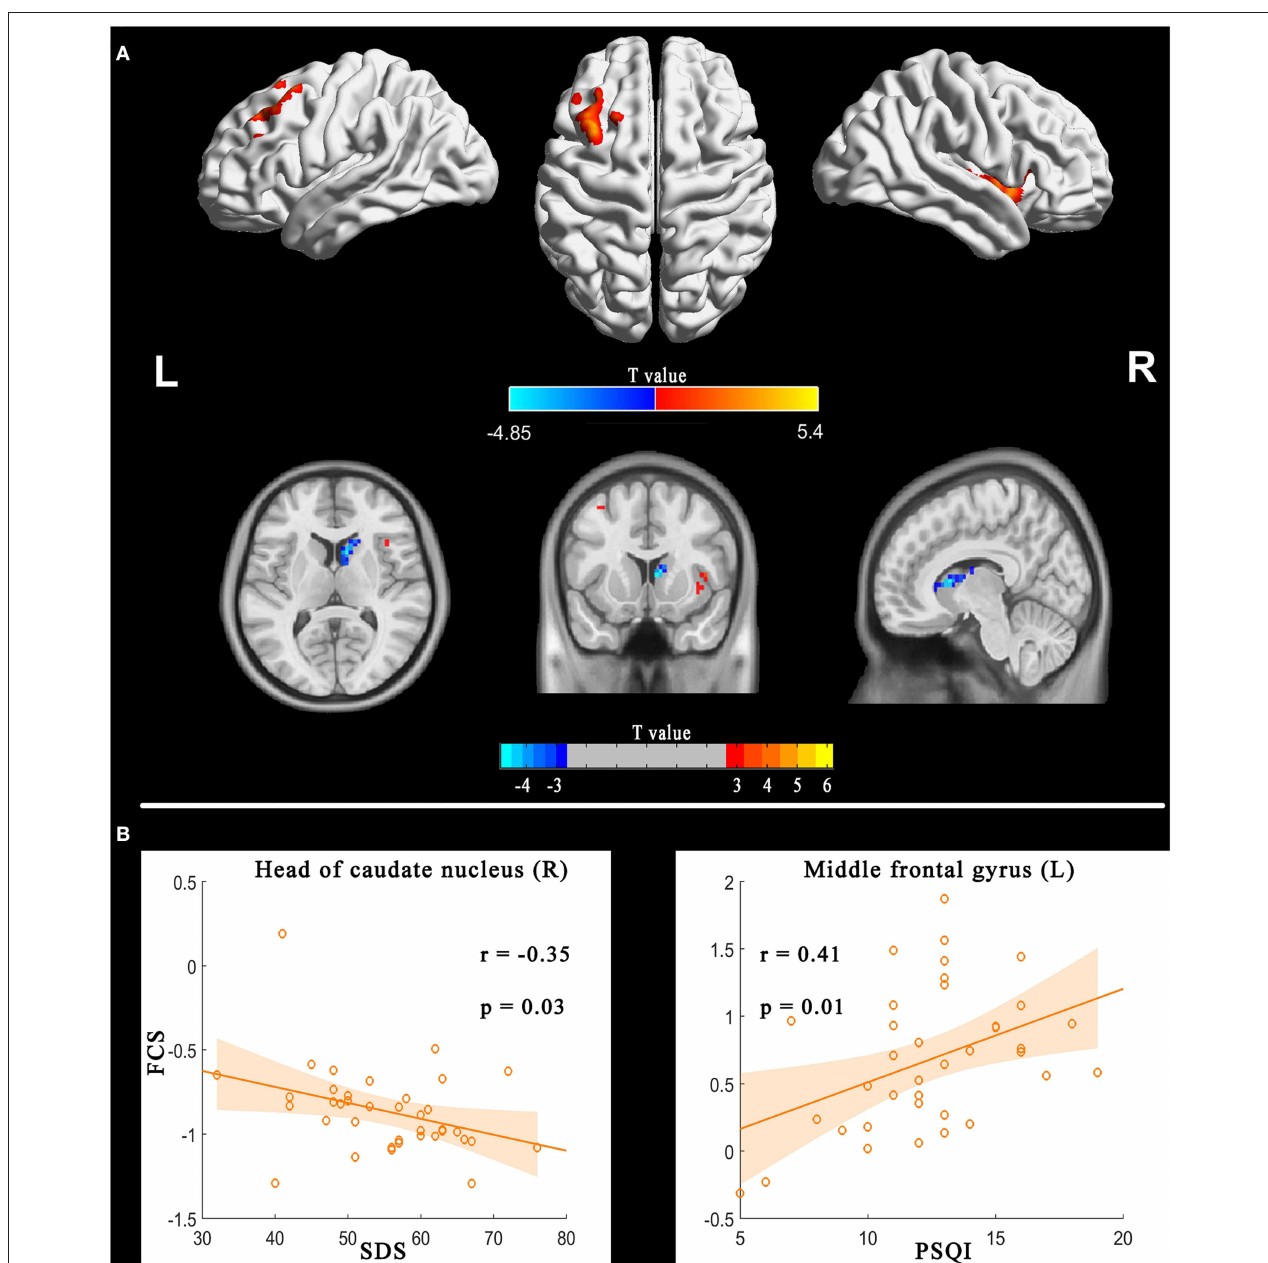
FIGURE 3 | FCS differences between PI patients and HC (PI-HC, A ) and correlation between FCS and sleep scales in the PI group (B) . The threshold was P < 0.01 at the voxel level, with Alphasim corrections for multiple comparisons of P < 0.05. The color bar represents the t value. FCS, functional connectivity strength; PI, primary insomnia; HC, healthy controls.